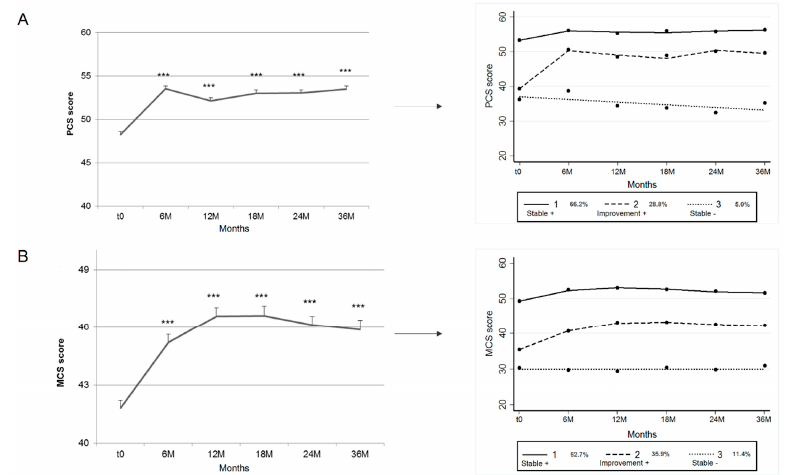
Figure 2. Trajectories of the long-term evolution of quality of life (PCS and MCS) following surgical treatment for endometriosis. For graphs A (PCS) and B (MCS), each curve represents mean ± standard error of the mean; ***: p < 0.001 compared to baseline. MCS: mental component summary; PCS: physical component summary. Table 2. Characteristics of pelvic pain and quality-of-life trajectories. Dysmenorrhea Trajectory 1 Trajectory 2 Trajectory 3 (Stable +) (improvement +) (Stable − )